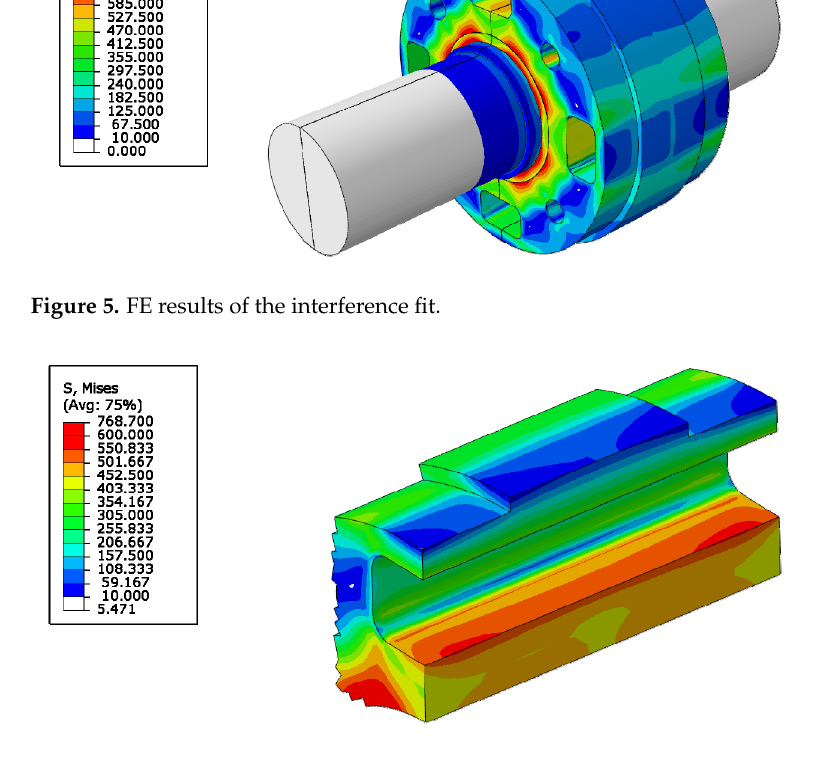
Figure 6. FE results of the interference fit, with a focus on the stress inside the sensor port.